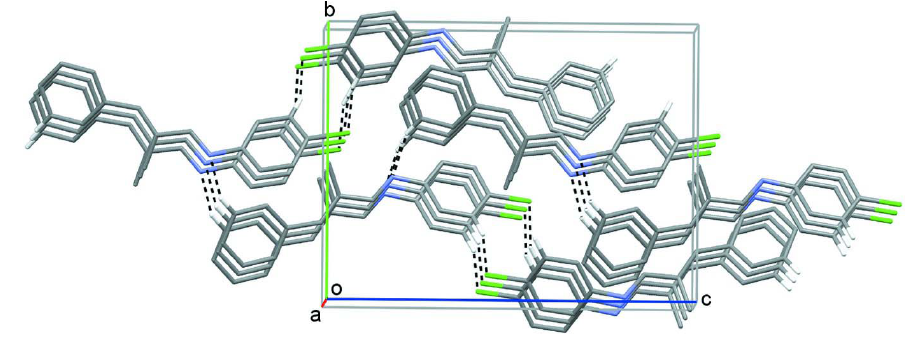
Figure 2 Crystal packing of (I) viewed down the a axis with hydrogen bonds drawn as dashed lines. H atoms not involved in hydrogen bonding have been